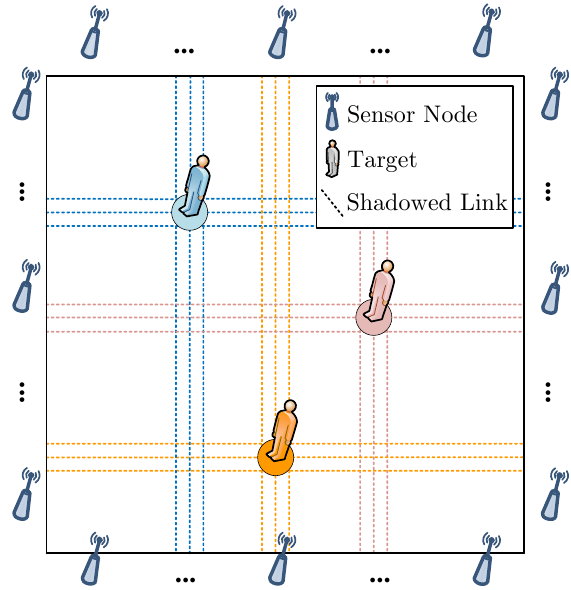
Figure 1. An illustration of CS-based multi-target DFL in